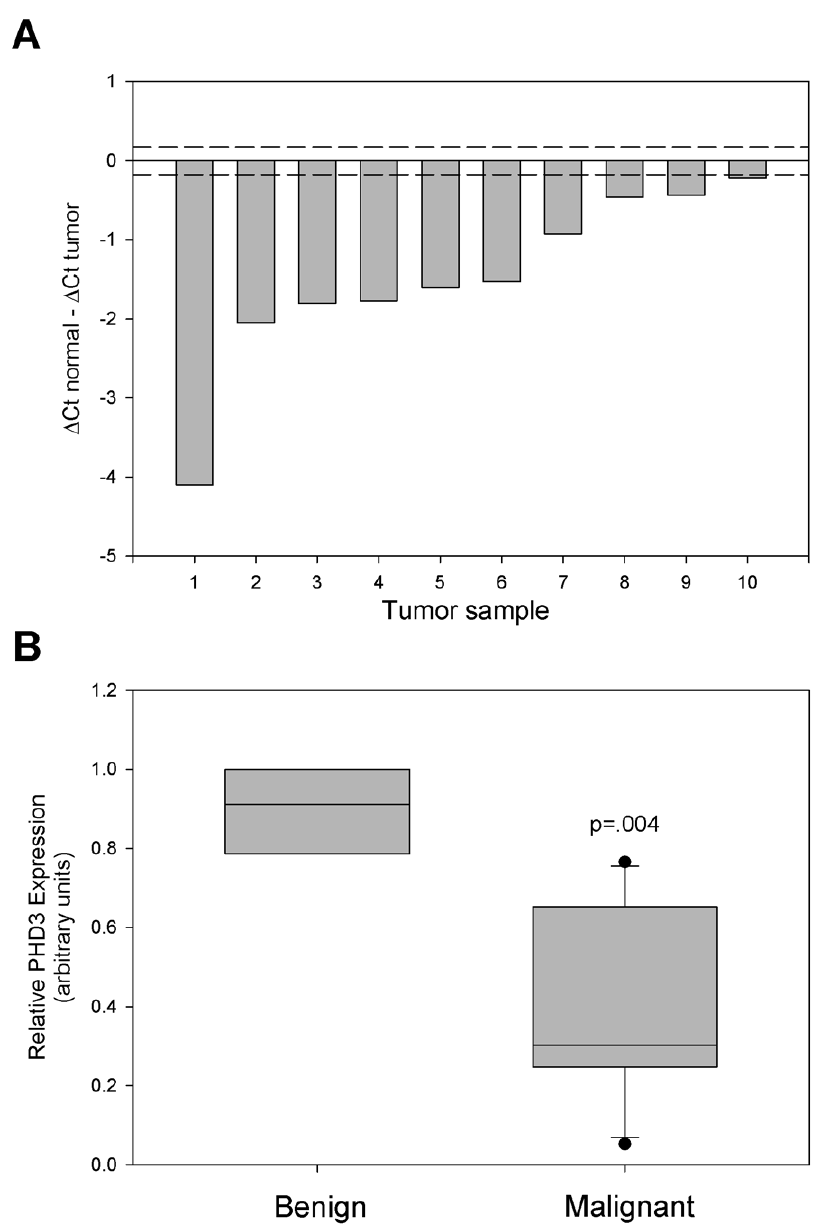
Figure 6. PHD3 mRNA expression is downregulated in multiple primary human prostate cancer specimens. A ) Total mRNA was isolated from frozen sections of primary human prostate cancer specimens with Gleason scores ranging from 7–9. Quantitative real-time PCR was performed using PHD3 specific TaqMan primer-probe. Relative PHD3 mRNA expression for each tumor sample is represented as (average dCt of n=3 benign prostate tissue samples) – (dCt tumor sample). Samples were normalized to GAPDH. Dotted lines represent + / 2 1 SD for benign tissue PHD3 mRNA expression. B ) Box plot depicting PHD3 mRNA expression from samples shown in A. p value is based on ANOVA between 3 benign samples and 10 malignant